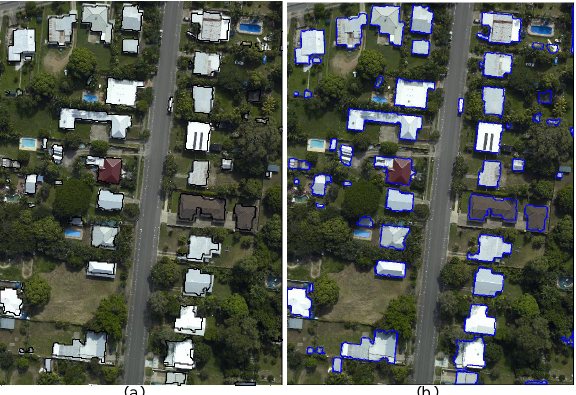
Figure 6. (a) Buildings before boundary expansion, (b) Final de- tected